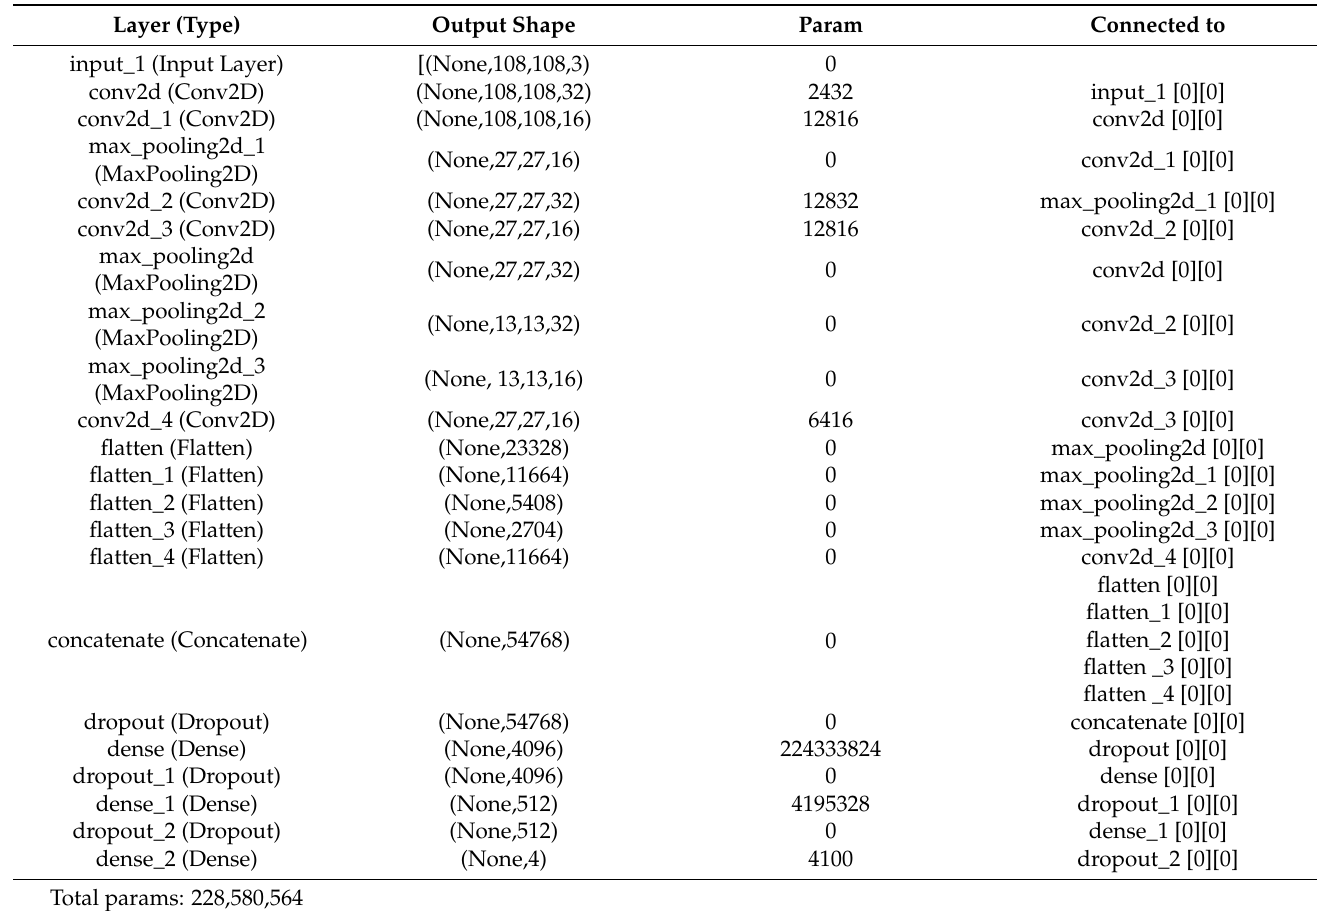
Table A1. Details of the proposed DS-SoybeanNet with 5 × 5